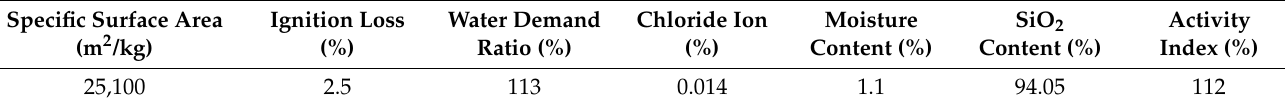
Table 9. Technical indicators of silica fume.